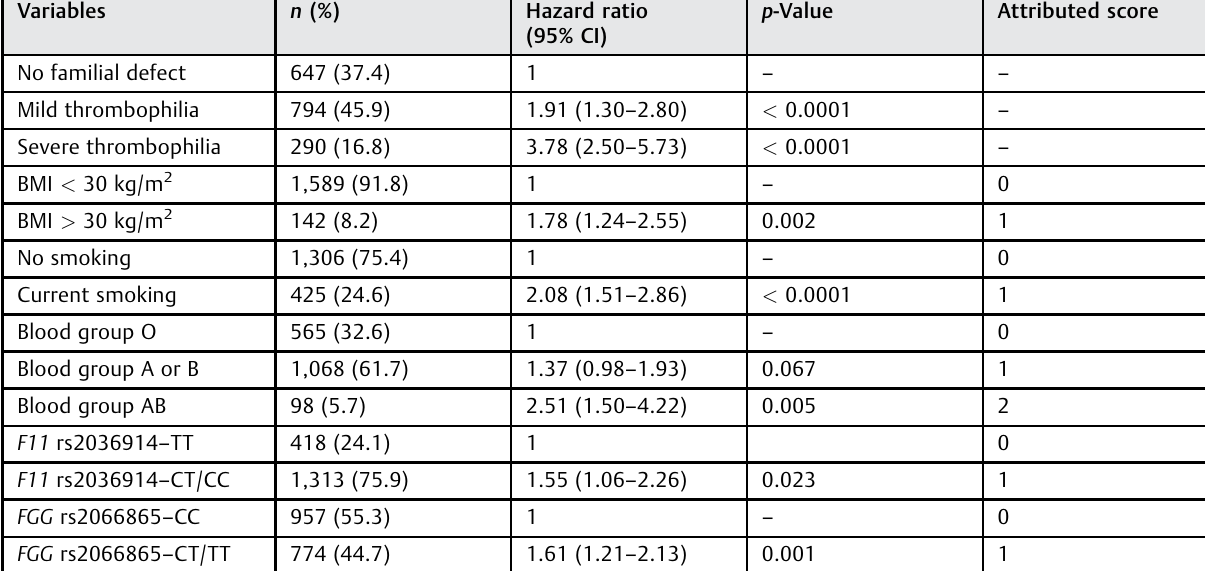
Table 3 Disease-free survival multivariate analysis with adjustment for age and gender and attributed score Variables